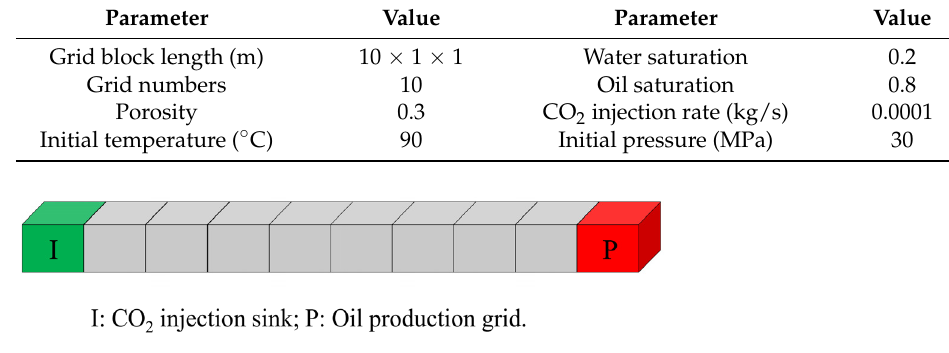
Figure 1. Validation model of CO 2 flooding.